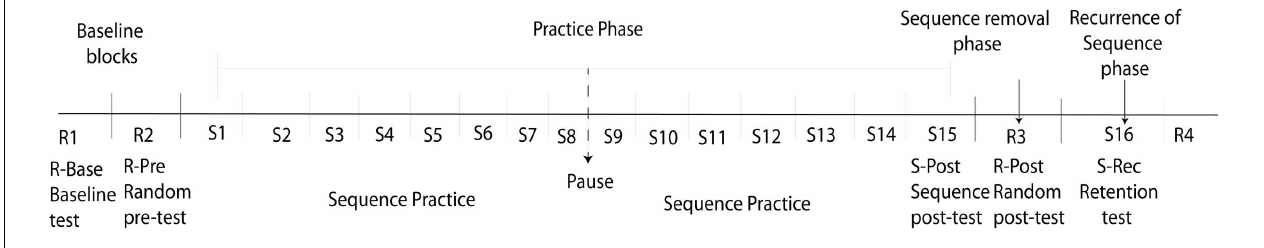
FIGURE 1 | Description of the experimental setup. R, random block; S, Sequence block.